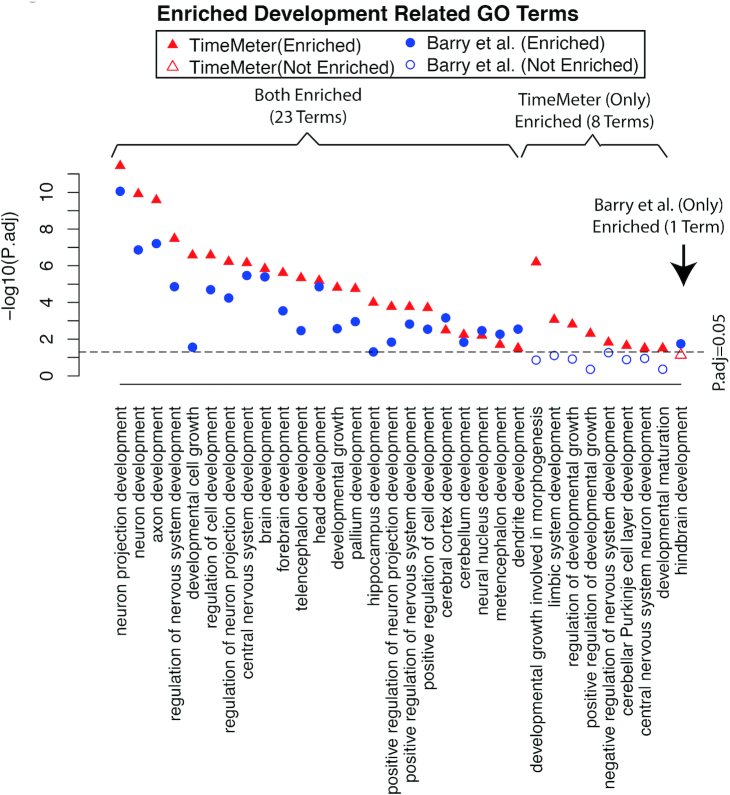
The increased specificity for detecting genes with similar temporal pattern (STP) of TimeMeter is not at the cost of losing sensitivity. There are 32 development related GO terms are enriched (P.adj < 0.05) in either TimeMeter or Barry et al. detected STP genes between human ES and mouse EpiS during neural differentiation. There are eight terms specifically enriched in TimeMeter detected STP genes (but not enriched in Barry et al. list) while there is only one term marginally enriched in Barry et al. list (but not enriched in TimeMeter list).